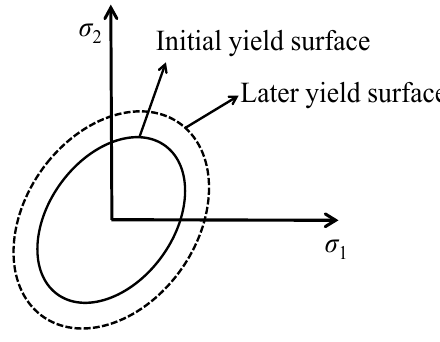
Figure 1. Diagram of the isotropic hardening rule. Nevertheless, the CSWs differ from those studied above. Due to the steel web’s bend angles and the welding’s geometric shape, the steel web details change suddenly [26]. For this reason, it is easy to produce stress concentration at the position of bend angles, which leads to comprehensive residual stress distribution. Currently, studies on the residual stress distribution in CSWs have been limited to consideration of the shear buckling resistance of corrugated webs. Kubo et al. [27] seem to be the first to study the distribution of residual stresses in corrugated webs, and they show that the welding flange clearly influences residual stresses. Koll á r [28,29] used numerical simulation to analyze the thermal phenomena in the welding process and their effect on the initial geometric defects of the waveform web. The difference between the presence of inclined folds in CSWS and the planar web may further change the distribution of residual stress [30,31]. In the design process of CSWs, it is necessary to clarify the influence of wave angle and welding path on residual stress. The above literature shows that the impact of the welding process, path, steel web bending angle, and other parameters on the residual stress distribution mechanism is not